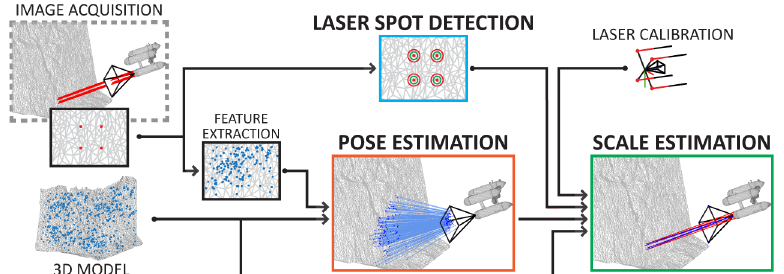
Figure 4. Flowchart of the scale estimation process depicting three crucial steps in scale estimation: laser spot detection, pose estimation, and scale